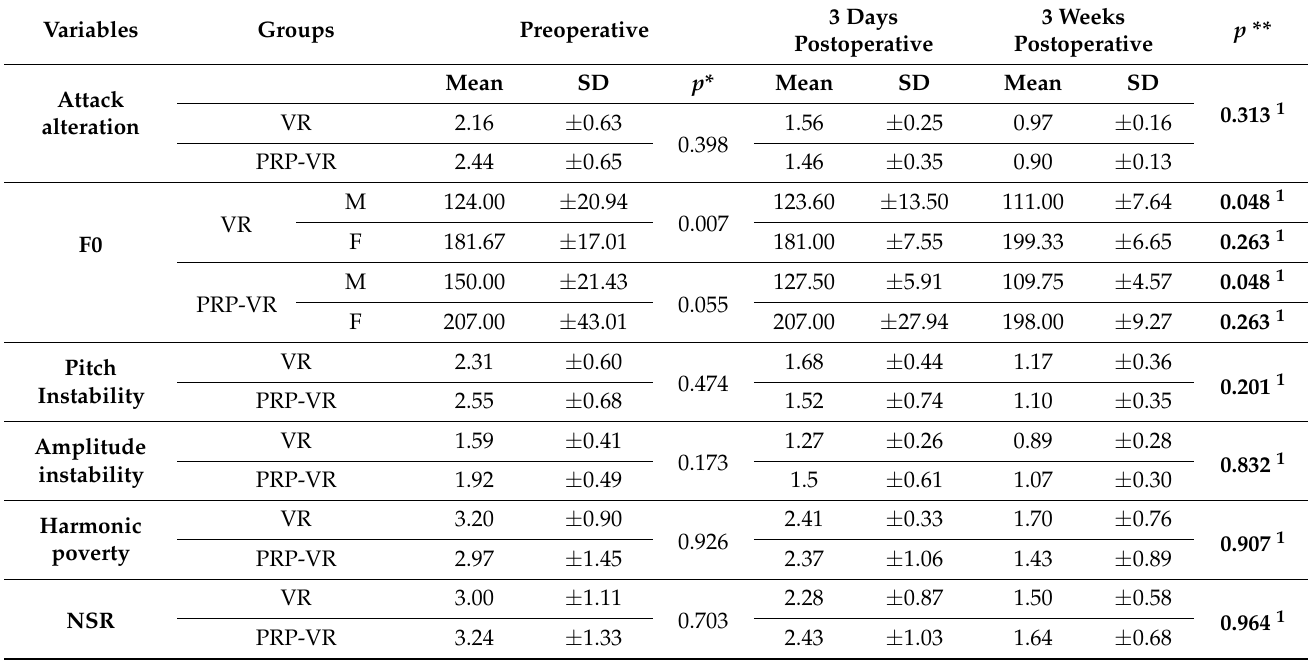
Table 3. Acoustic analysis comparison between PRP-voice rest and voice rest groups VR = voice rest group.